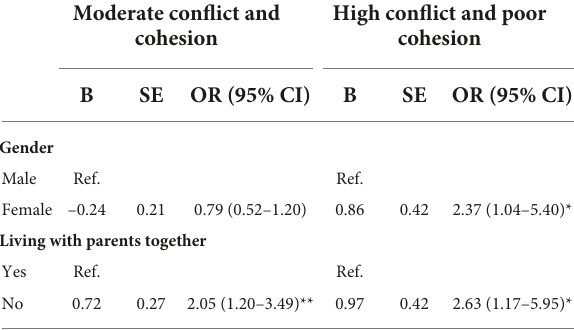
TABLE 2 Multinomial logistic regression for the effects of correlates on the latent profiles. Moderate conflict and